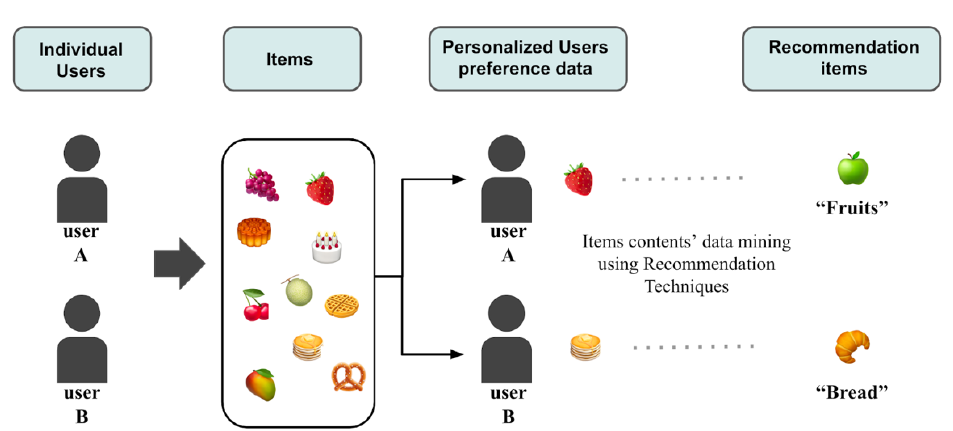
Figure 6. Recommendation principle of Contents-Based Filtering Model.